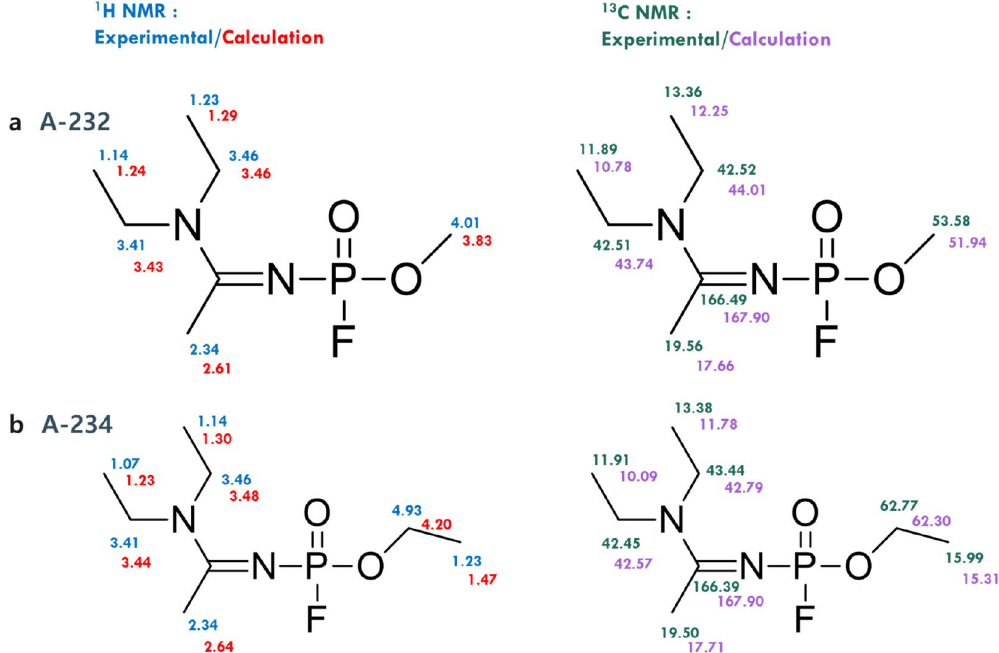
Figure 5. Comparison between experimental and predicted data for 1 H and 13 C NMR chemical shift of A-232 ( a ) and A-234 ( b ), which was used in the UK, in DMSO. DMSO was used for experimental sampling; therefore, the B3LYP/6-31 + G(d,p) and PBE0/6-311 + G(2d,p) functionals/basis set combinations were used for the DFT